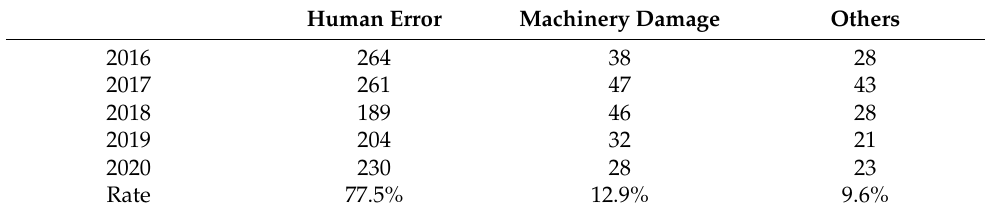
Table 1. Summary of marine accidents in Korea between 2016 and